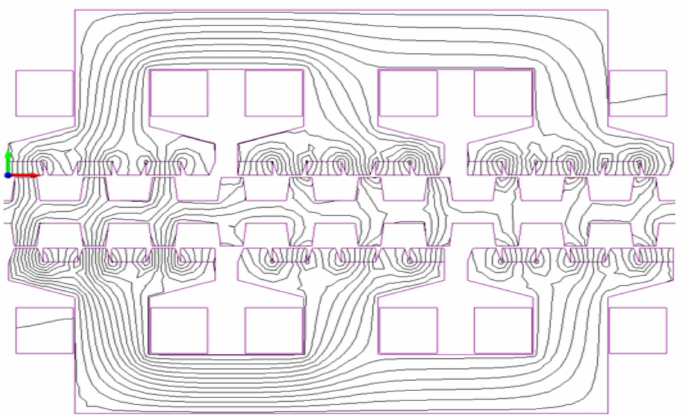
Figure 6. No load flux pattern for an E-core consequent pole linear vernier hybrid